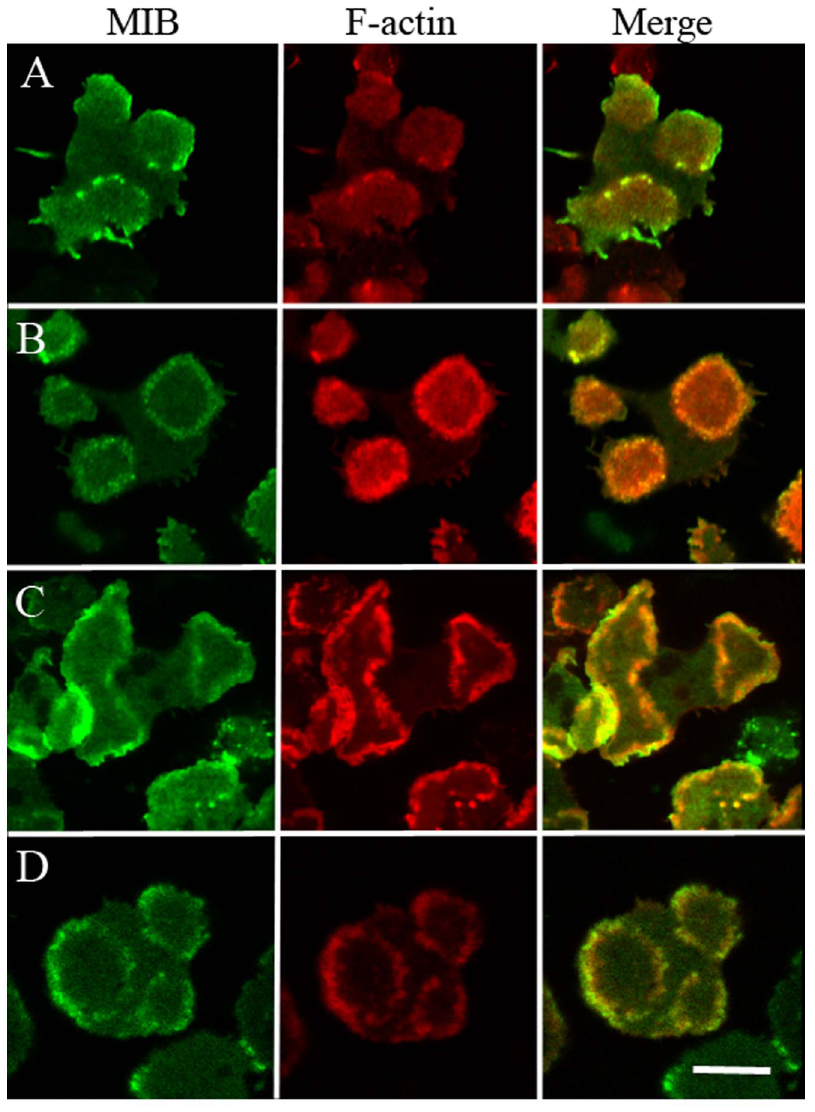
Figure 2. MIB colocalizes with F-actin in waves in cells treated in different ways. GFP-MIB and mRFP-lifeact were expressed in myoB 2 -cells in: (A) cells in nutrient media; (B) cells starved for 1 h; (C) cells recovering from treatment with 7.5 m M latrunculin that was washed out, cells were starved before latrunculin treatment; (D) cells in starvation buffer in the presence of 1 m M latrunculin. See Materials and Methods for details of cell treatment. Bar is 10 m